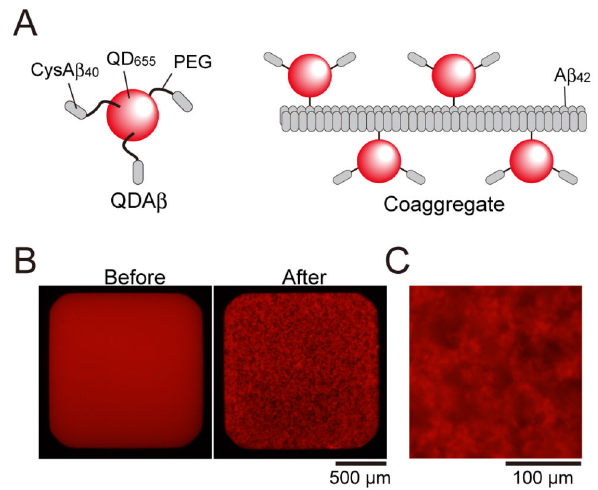
Figure 1. Imaging of Aβ aggregation using a QDAβ 42 nanoprobe. (A) QDAβ was prepared by crosslinking CysAβ 40 and amino (PEG) Qdot655 according to our recent study [12] (left). QDAβ coaggregated with unlabeled Aβ , and the Aβ 42 42 fibrils that formed could be visualized under fluorescence microscopy (right). (B) 30 nM QDAβ and 30 µM unlabeled Aβ 42 was incubated at 37 ° C for 24 h in a 1536-well plate, and was observed using an inverted fluorescence microscope using a 4x objective. Left and right panels show before and after incubation, respectively. (C) Magnified image of the aggregates observed using a 10× objective.